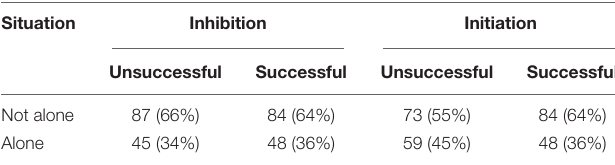
TABLE 3 | Frequency and percent of self-control challenges that occurred alone and not alone. Situation Inhibition Initiation